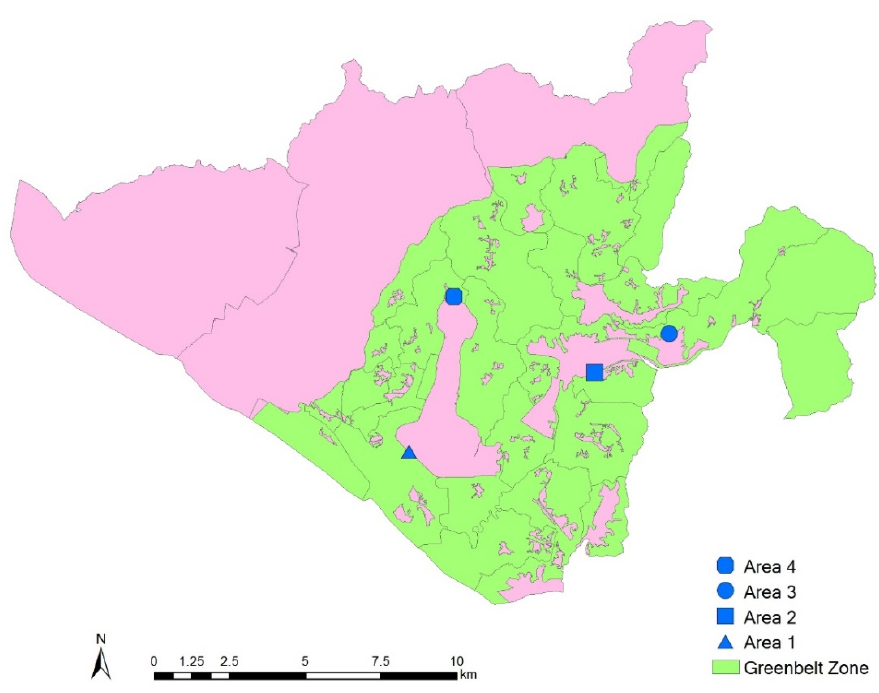
Figure 4. Targeted areas.